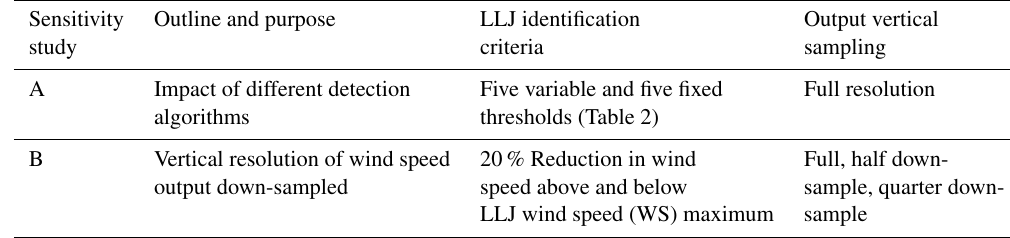
Table 1. Summary of the LLJ sensitivity studies A and B.